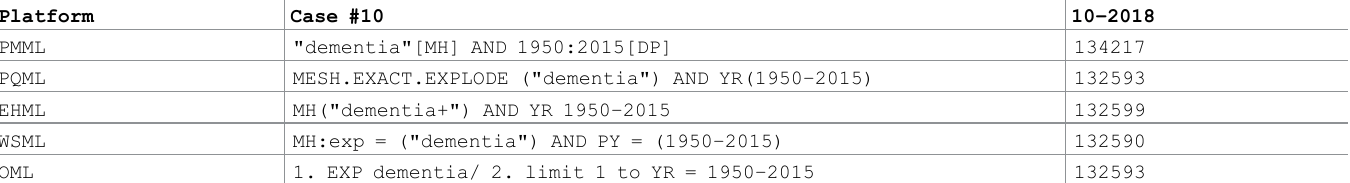
Table 1. Case #10 showing semantically equivalent but syntactically different queries for five MEDLINE platforms.